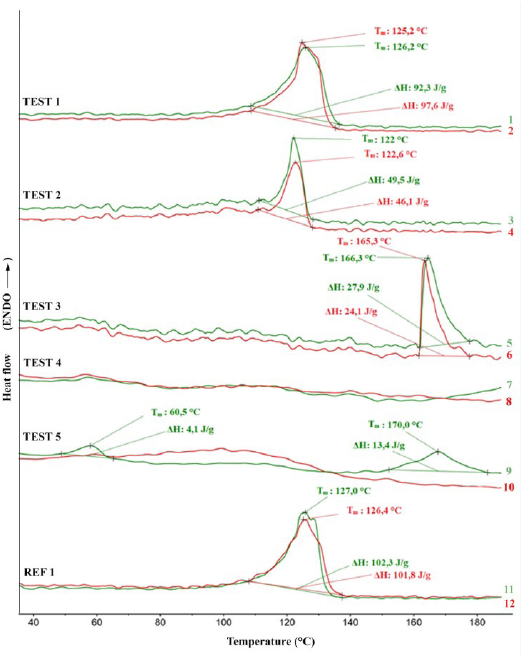
Figure 6. DSC first heating thermograms of TEST 1 (curves 1 and 2), TEST 2 (curves 3 and 4), TEST 3 (curves 5 and 6), TEST 4 (curves 7 and 8), TEST 5 (curves 9 and 10) and REF 1 (curves 11 and 12) samples after the biodegradation soil test (red curves) compared to the initial samples (green